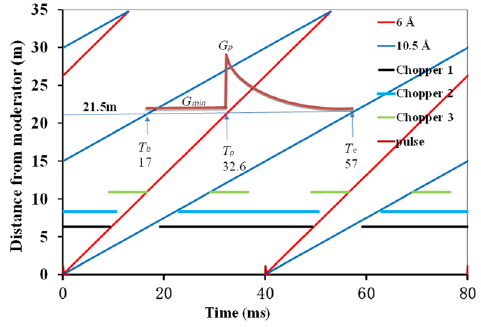
Figure 3. Time-distance diagram of the CSNS-VSANS instrument. As for an electromagnet, it is quite simple to generate a magnetic field that decays inversely with the square of time. When it comes to the Nest-Rot-SPM, the rotational speed of the motor must be regulated to modulate the magnetic field. When the motor rotates at a constant speed, the magnetic field gradient variation follows a cosine function from G min to G max